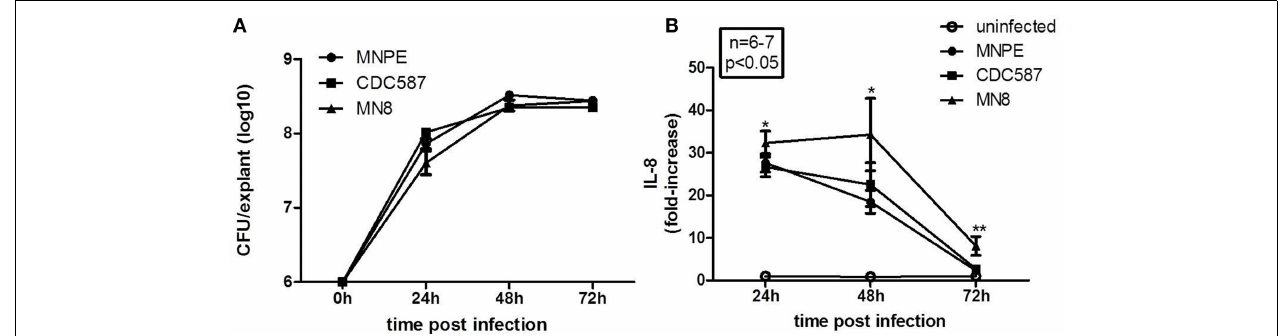
FIGURE 2 | Staphylococcus aureus ( hla + and hla − ) grow to similar densities on the mucosal tissue and are proinflammatory. (A) Quantitation of bacteria growth on tissue. Bacteria were recovered from unwashed explants infected with MNPE (circles), CDC587 (squares), or MN8 (triangles).The initial inoculum was ∼ 1 × 10 6 CFU/explant. After the indicated time, explants were transferred to tubes containing 250 μ l PBS and vortex mixed for 4min to recover bacteria. Supernatants were serially diluted in PBS and plated onTSB agar. Over the first 24–48h, the bacteria grew logarithmically.There was no change in density from 48 to 72h. Data are the combined results of two experiments, with n = 3 each. (B) Quantitation of IL-8 from the tissue during the course of infection. Explants of porcine vaginal mucosa were infected with ∼ 1 × 10 6 CFU